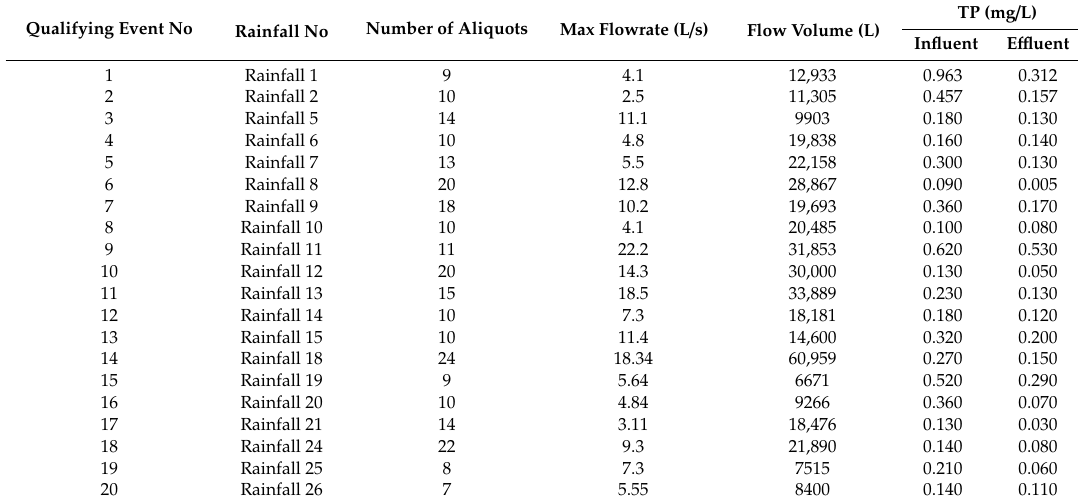
Table A2. TP influent and e ffl uent results ( LOD = 0.01 mg / L).